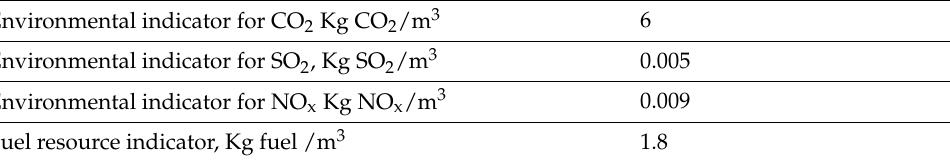
Table 3. Sustainability composition of RO plant with local power source. Environmental indicator for CO 2 Kg CO 2 /m 3 6 Environmental indicator for SO 2 , Kg SO 2 /m 3